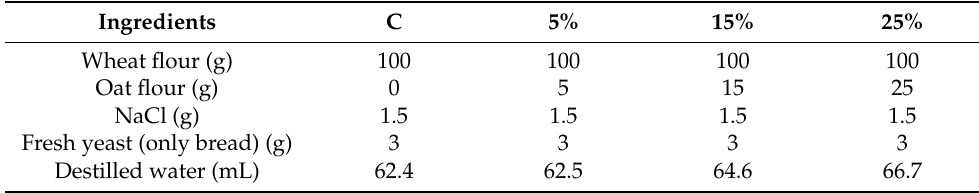
Table 1. Formulation of different wheat and oat flour